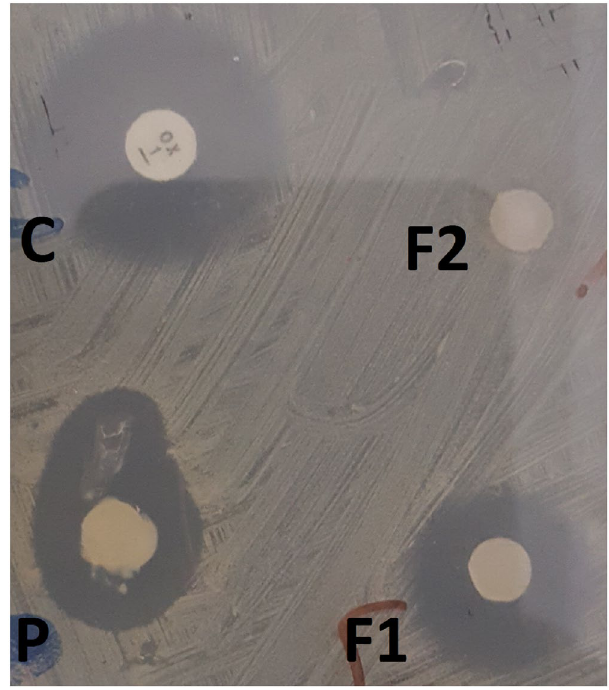
Figure 5. Antibacterial activity of the prepared formulations (F1 and F2) against Staphylococcus aureus , determined by disc diffusion antibiotic sensitivity method. C: control; Oxacillin antibiotic disc, P: commercial product; silver sulphadiazine, F1: (AuNPs-PF127) and F2: